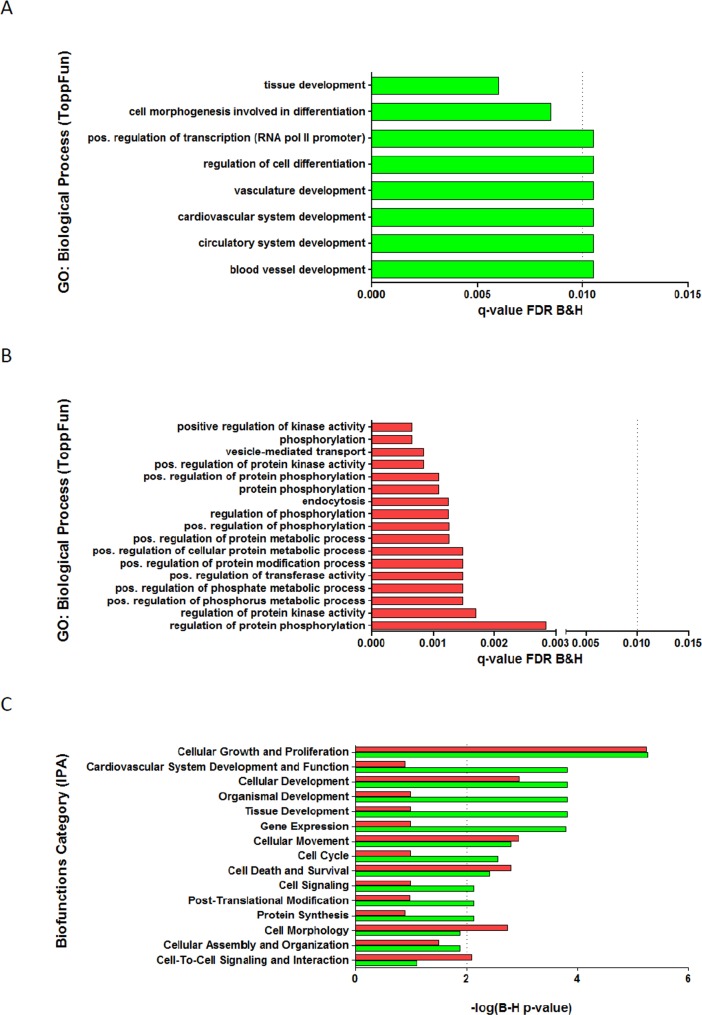
Best enrichment gene lists.Analysis of functional gene enrichment using ToppFun tool (application of ToppGene Suite) for A) up-regulated and B) down-regulated DEG between 40 QMR setting and control with significant enrichment (dotted line) for FDR B&H q-value <0.01); C) Comparative analysis of up-regulated (green bar) and down-regulated (red bar) functional gene enrichments using IPA software with significant enrichment (dotted line) for -log2 (B-H p-value) >2.